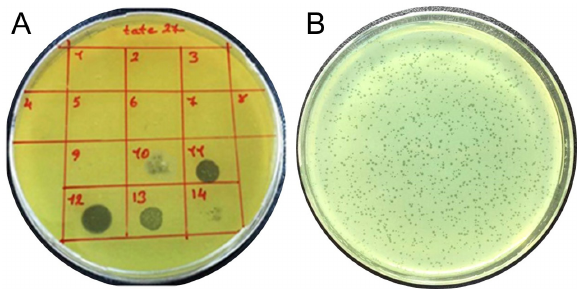
Figure 1. a,b. (a) Initial isolation of phages by the agar spot assay using Pseudomonas aeruginosa TRPA 28 as host. (1) Enas3, (2) Enas9, (3) Kleb11, (4) Acpi12, (5) Citroy14, (6) Citrof16, (7) Enteroc21, (8)